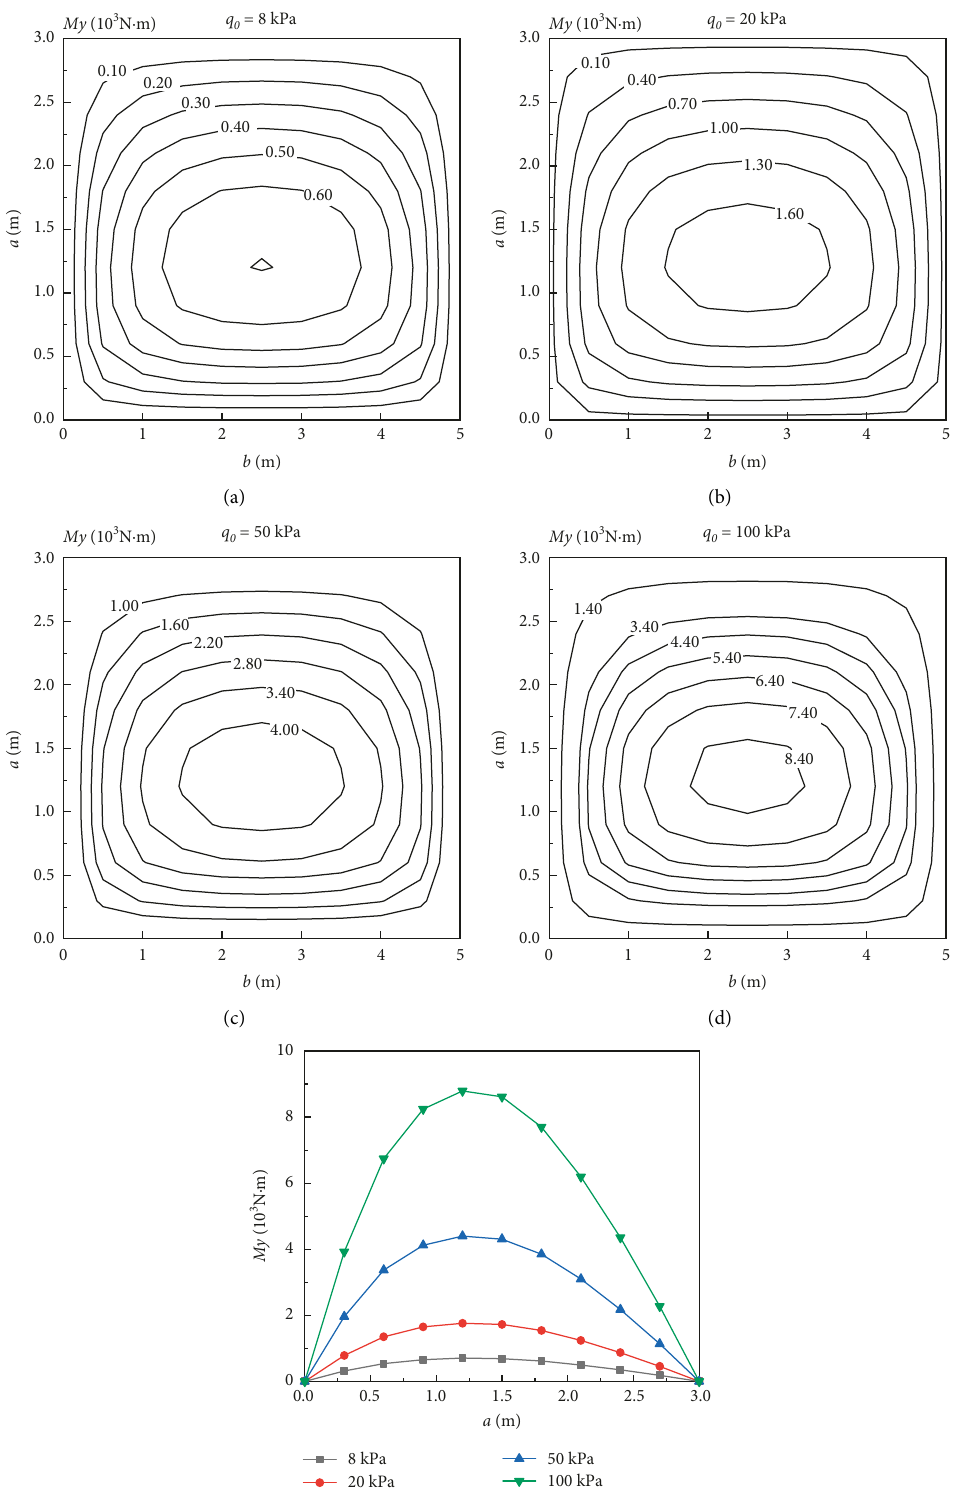
Figure 8: Effect of frost heaving force on bending moment M